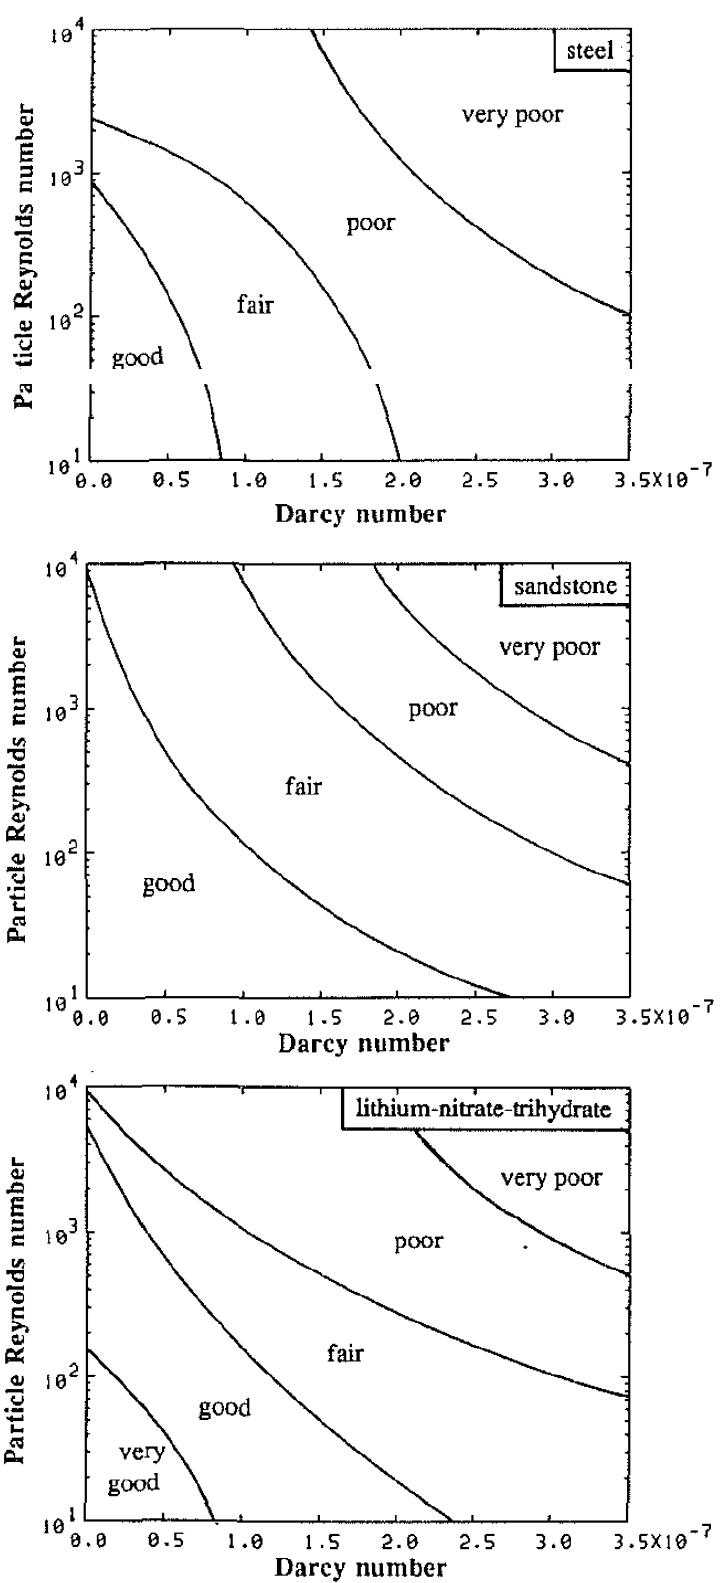
Figure 15. Qualitative assessment of the legality of LTE assumption for steel, sandstone, and lithium- nitrate-trihydrate materials, reported by Vafai and Sözen